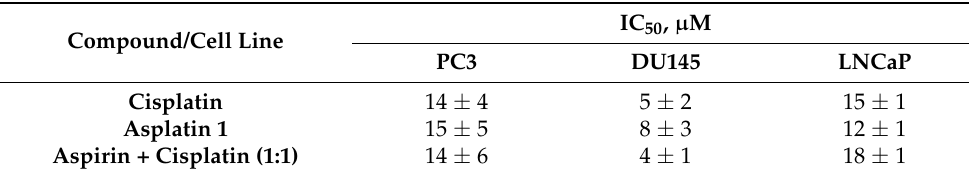
Figure 2. Synthesis of Platin A (asplatin) 1 , the first cisplatin-based Pt(IV) prodrug with a NSAID as an axial ligand. DMSO -dimethylsulfoxide; r.t.—room temperature. The ability of asplatin 1 to reduce was measured using cyclic voltammetry (CV) under two pH values. The change of pH value from 7.5 to a more acidic value of 6.4 was followed by E(Pt +4 /Pt +2 ) reduction potential increase by 42 mV, thus allowing the authors to assume that prodrug 1 will be easily reduced in tumor tissues. In model conditions that mimic intracellular reduction, Platin-A 1 was incubated with sodium ascorbate and 2 (cid:48) - deoxyguanosine 5 (cid:48) -monophosphate sodium salt hydrate (5 (cid:48) -GMP). Analysis of the reaction products by matrix-assisted laser desorption ionization (MALDI) mass-spectrometry (MS) showed the formation of Pt-GMP 2 bis adduct, [Pt(NH 3 ) 2 (5 (cid:48) -GMP) 2 ], thus proving the ability of Platin-A 1 reduction products to interact with guanosine bases in DNA [20]. The release of aspirin upon reduction of the prodrug was proved by HPLC; upon the reduction of prodrug 1 in the presence of sodium ascorbate, an increasing amount of aspirin and salicylic acid release from the prodrug was detected. This proves that platinum (IV) prodrugs are able to release active platinum(II) moieties and axial ligands in either pristine or metabolite form upon reduction [20]. Table 2. Antiproliferative activity of cisplatin, asplatin 1, and an equimolar mixture of cisplatin + aspirin on the prostate tumor cell lines PC3 (androgen independent human prostate adenocarcinoma cells), DU145(androgen independent human prostate adenocarcinoma cells), and LNCaP (androgen-sensitive human prostate adenocarcinoma